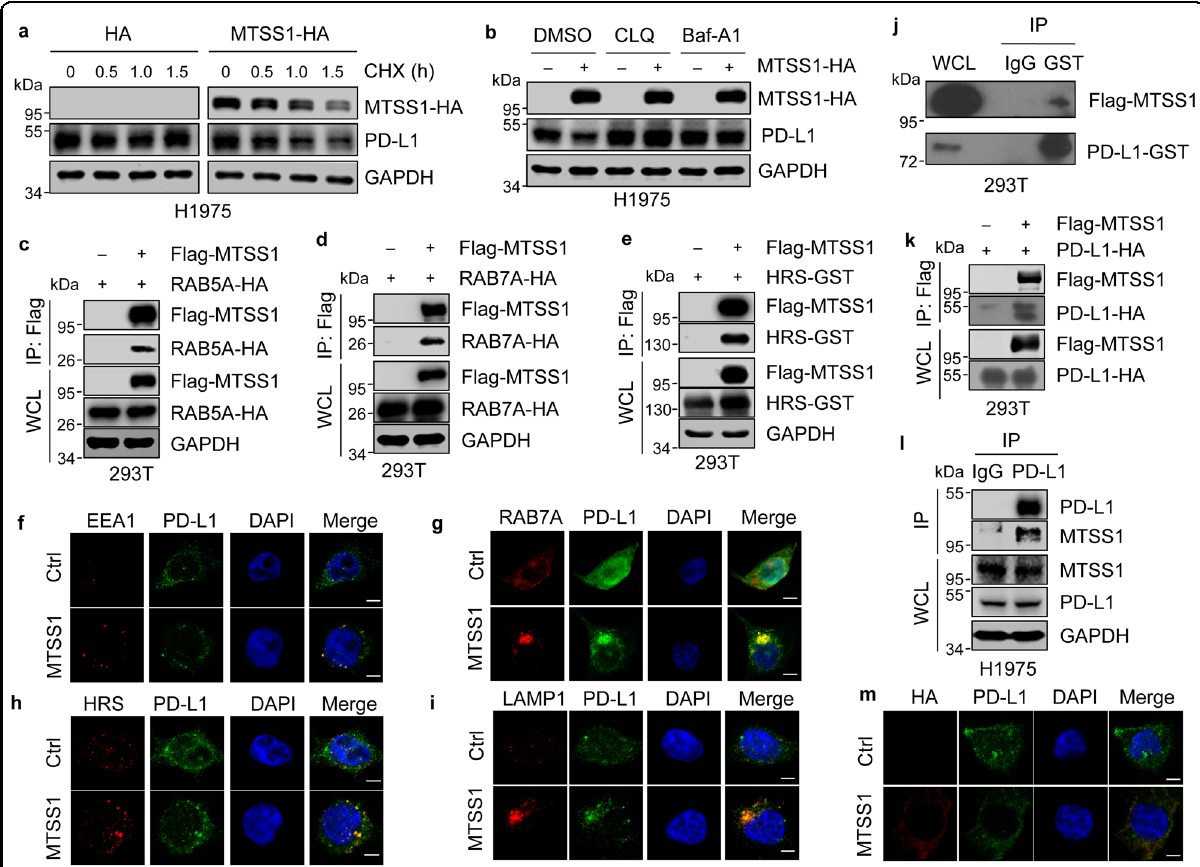
Fig. 3 MTSS1 interacts with PD-L1 and promotes PD-L1 lysosomal degradation. a , b PD-L1 protein levels in H1975 cells with or without MTSS1 overexpression with the treatment of cycloheximide (CHX, 100 μ M) for the indicated duration ( a ), or lysosome inhibitors chloroquine (CLQ, 150 μ M) or ba fi lomycin-A1 (Baf-A1, 0.4 μ M) for 12h ( b ). c – e Co-immunoprecipitation (Co-IP) of ectopically expressed MTSS1 with endocytic organelle markers RAB5A ( c ), RAB7A ( d ), and HRS ( e ) in 293 T. WCL, whole cell lysates. f – i Immuno fl uorescence (IF) analysis for colocalization of PD-L1 with endocytic organelle markers EEA1 ( f ), RAB7A ( g ), HRS ( h ), and LAMP1 ( i ) in H1975 cells with or without MTSS1 overexpression. j , k Co-IP of ectopically expressed MTSS1 and PD-L1 in 293T by detecting MTSS1 in PD-L1 (GST tagged) immunoprecipitates ( j ) and detecting PD-L1 in MTSS1 (Flag tagged) immunoprecipitates ( k ). l Co-IP of endogenous MTSS1 and PD-L1 in H1975. m IF analysis for MTSS1 and PD-L1 colocalization in H1975. Scale bars, 5 μ